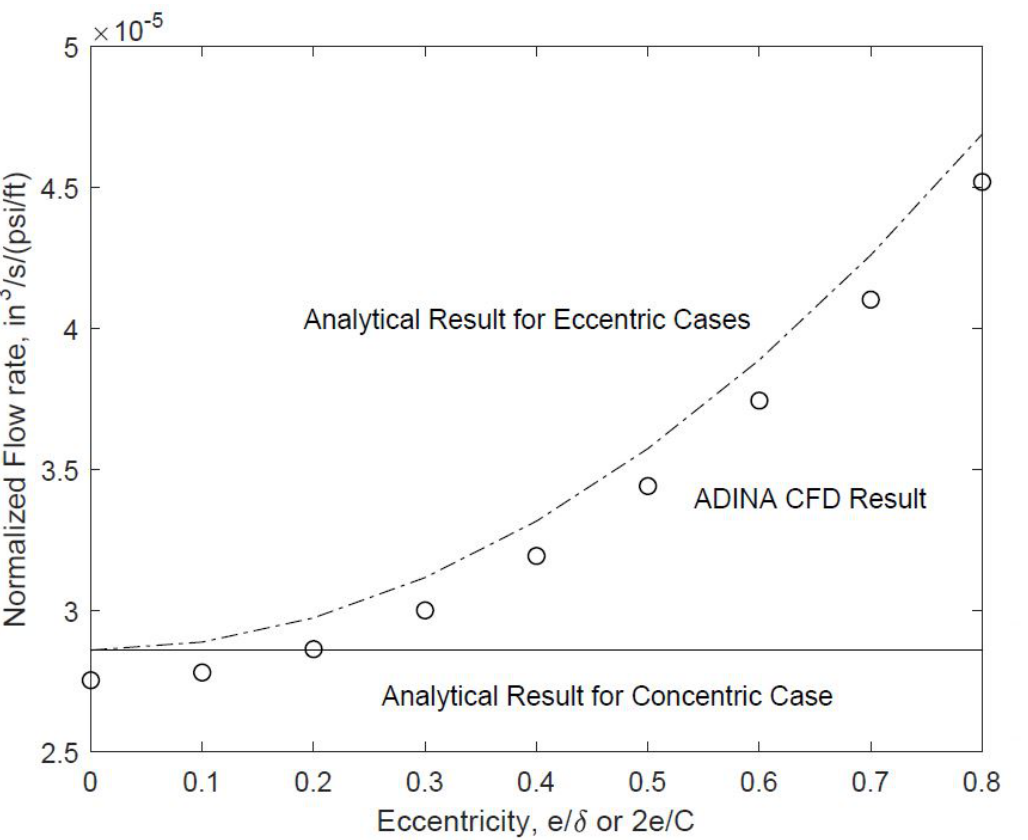
Figure 7. Eccentricity effects on the flow rate through the annulus